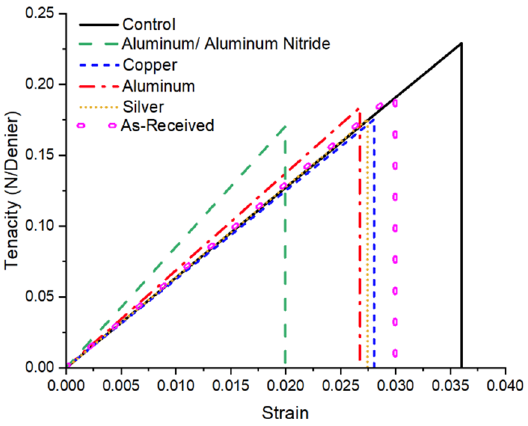
Figure 17. Representative yarn tensile of all groups.